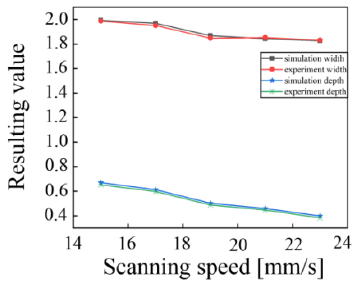
Figure 7. Variation rule of scanning speed on molten pool size.